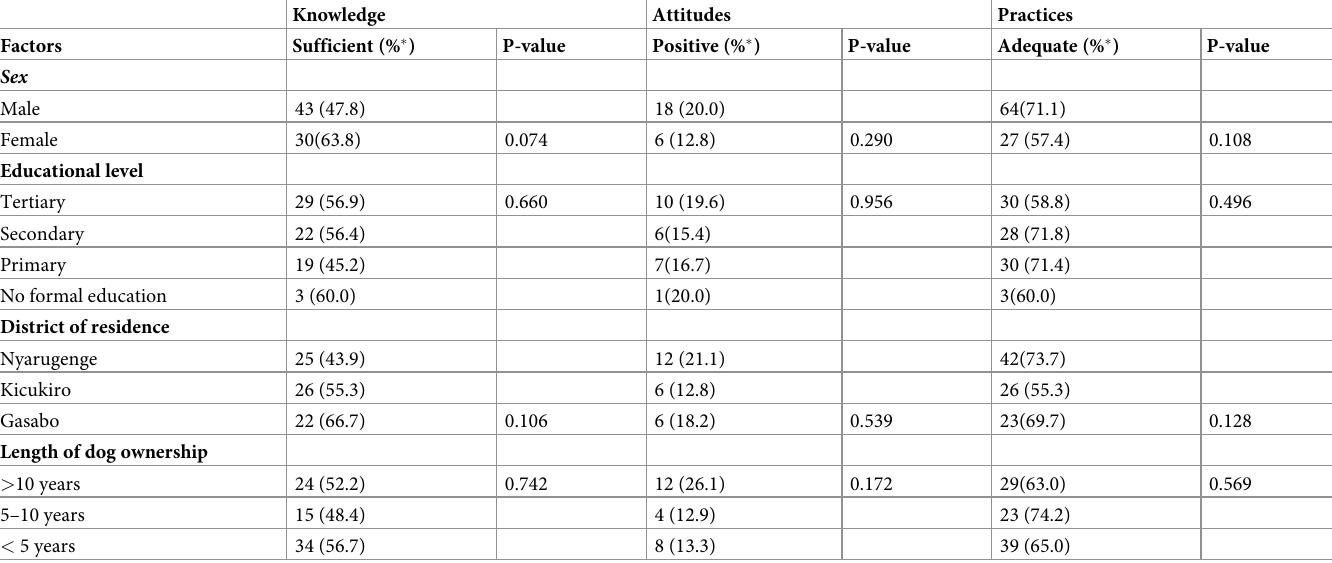
Table 5. Test of associations ( χ 2 ) between the respondents’ knowledge, attitudes and practices towards rabies in Kigali, Rwanda (n = 137). Knowledge